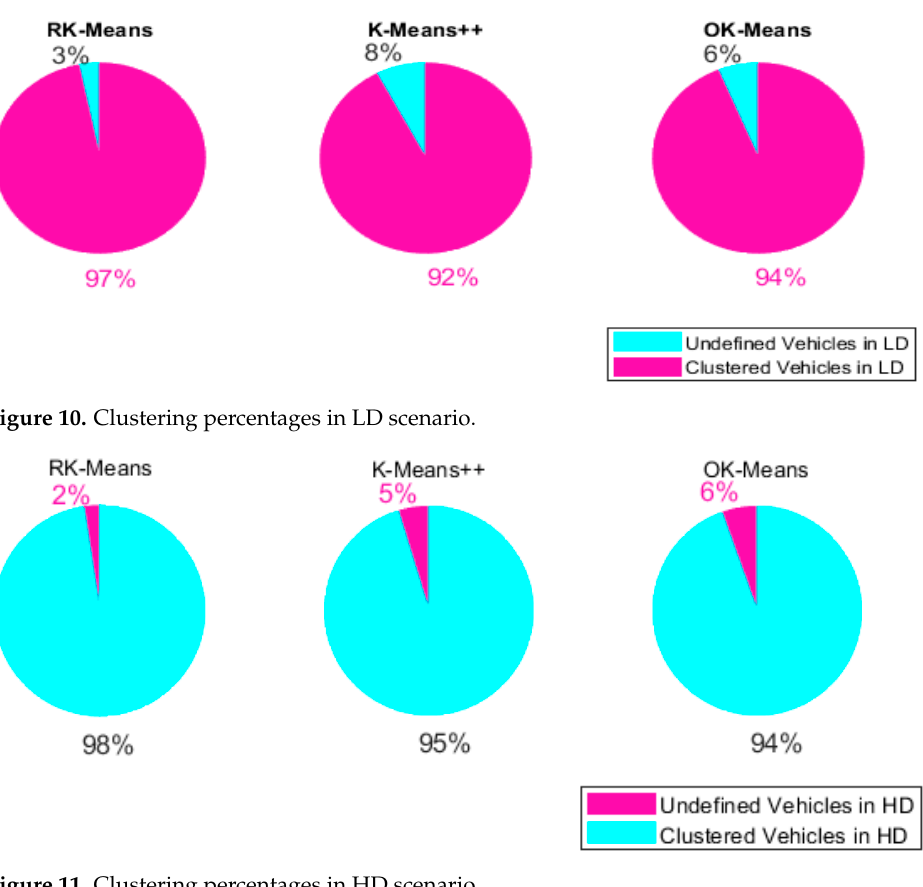
Figure 11. Clustering percentages in HD scenario.